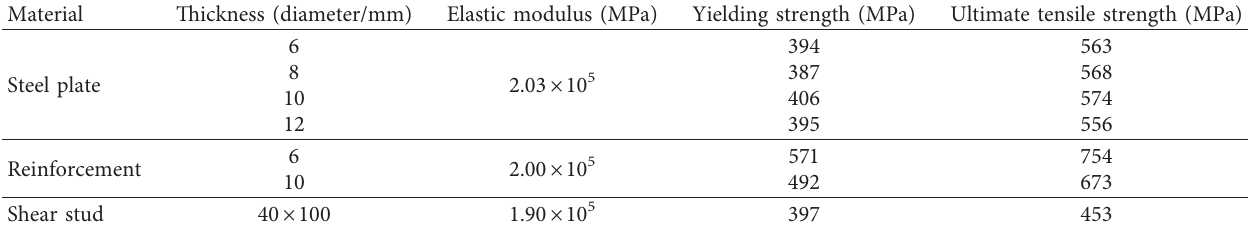
Table 3: Material properties of steel.